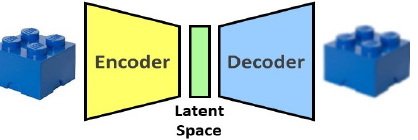
Figure 6. Basic topology of an AE. The latent values contain the key information for generating the original